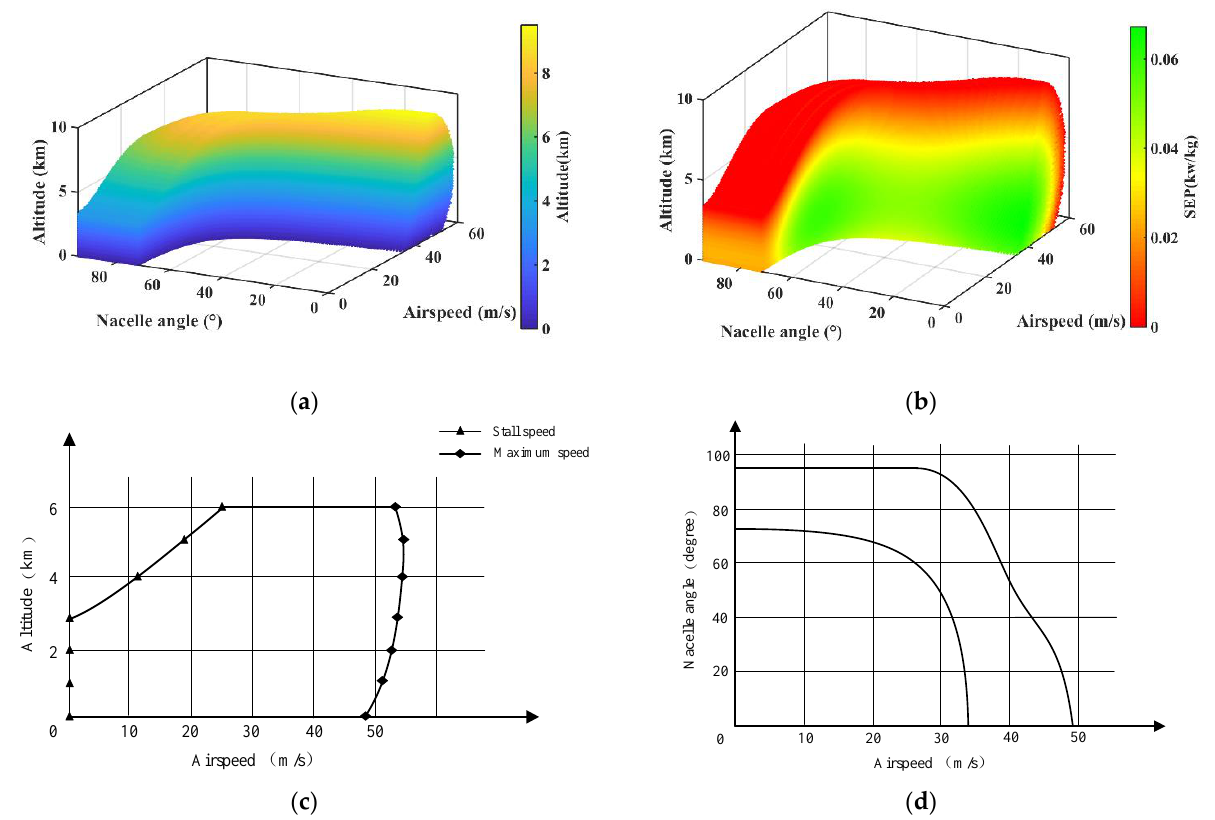
Figure 11. ( a ) 3D flight envelope of the rotor wing; ( b ) 3D flight envelope colored by SEP of the rotor-wing; ( c ) the flight envelope from 3D envelope; and ( d ) the conversion corridor at sea level.